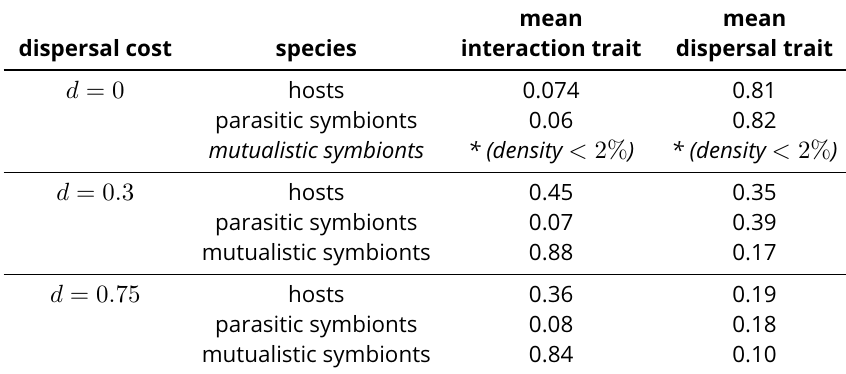
Table SI.1. Features of the clusters in the traits